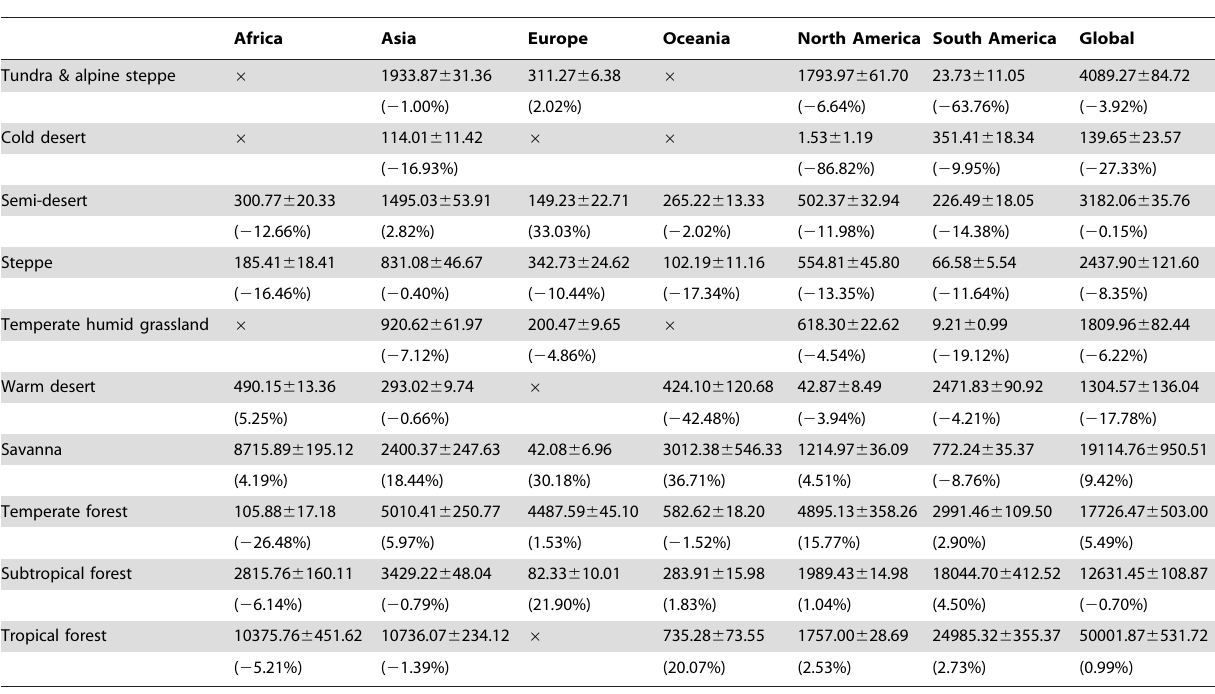
Figure 2. Spatial distribution of global natural vegetaiton biomes in the period 1911–2000. (a): T1 period (1911–1940), (b): T2 period (1941–1970), (c): T3 period (1971–2000). The different colors represent the different ecosystems, tundra & alpine steppe (12.85%), cold desert (1.56%), warm desert (13.93%), semi-desert (5.96%), savanna (17.66%), steppe (3.29%), temperate humid grassland (5.86%) and Forest (39.65%) in T3 period. doi:10.1371/journal.pone.0080394.g002 desert was basically flat with a slight increase (0.15%) in the same period. Continental distributions of terrestrial NPP are shown in Table 3. From a climatic regions perspective, vegetation NPP in the tropical region (Figure. 5(a)), which amounted to more than half of total terrestrial ecosystem NPP, increased slightly by 1.32% in the period 1911–2000. The NPP of tropical forest and savanna took up nearly 60% and 25%, respectively, of that tropical region. The NPP of savanna in this period increased remarkably by 1441.82 Tg DW yr 2 1 (8.99%), while the increasing trend of tropical forest (0.70%) was relatively low. In contrast, a declining trend of NPP was observed in other ecosystems. For instance, the decrease in warm desert was remarkable (21.40%). The NPP of ecosystems in the northern frigid zone also increased slightly overall (0.16%) over the course of the entire study period (Figure. 5(b)). Temperate humid grassland was estimated to increase by 21.21 Tg DW yr 2 1 (7.95%). The NPP of steppe and temperate forest also went up by 7.13 Tg DW yr 2 1 and 6.81 Tg DW yr 2 1 , respectively. A slight decrease (1.11%) was observed in tundra & alpine steppe, the NPP of which occupied nearly 90% of vegetation NPP in the northern frigid zone. As can be seen in Figure 5 (c) and (d), the NPP in the northern temperate zone is nearly seven times that of the southern temperate zone, and both increased gradually in this period by 3.55% and 8.27%, respectively. In the northern temperate zone, the temperate forest NPP amounted to more than 50% of the total and contributed the Table 1. Areas of terrestrial ecosystems at continental levels in